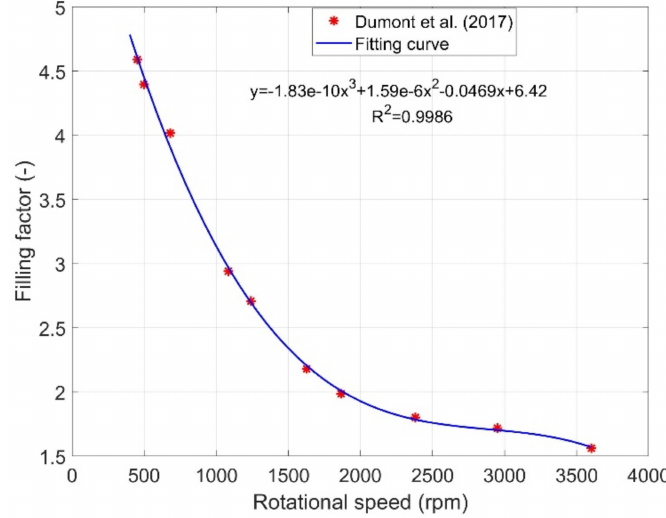
Figure 3. Filling factor as a function of the rotational speed based on data from Dumont et al. [61].